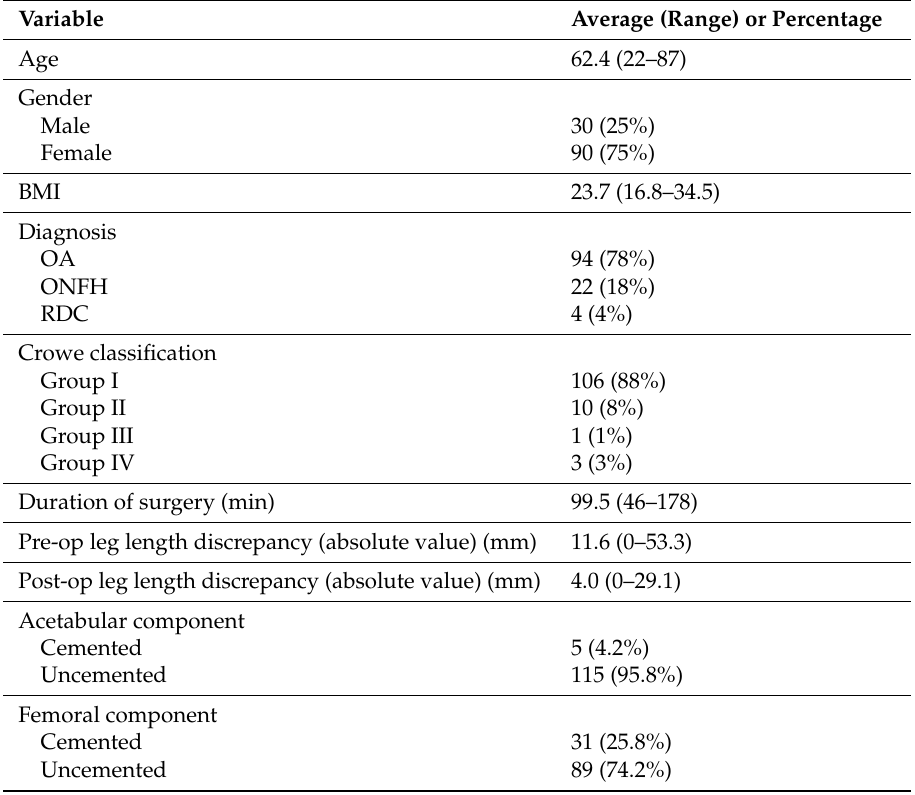
Table 1. Patient demographic